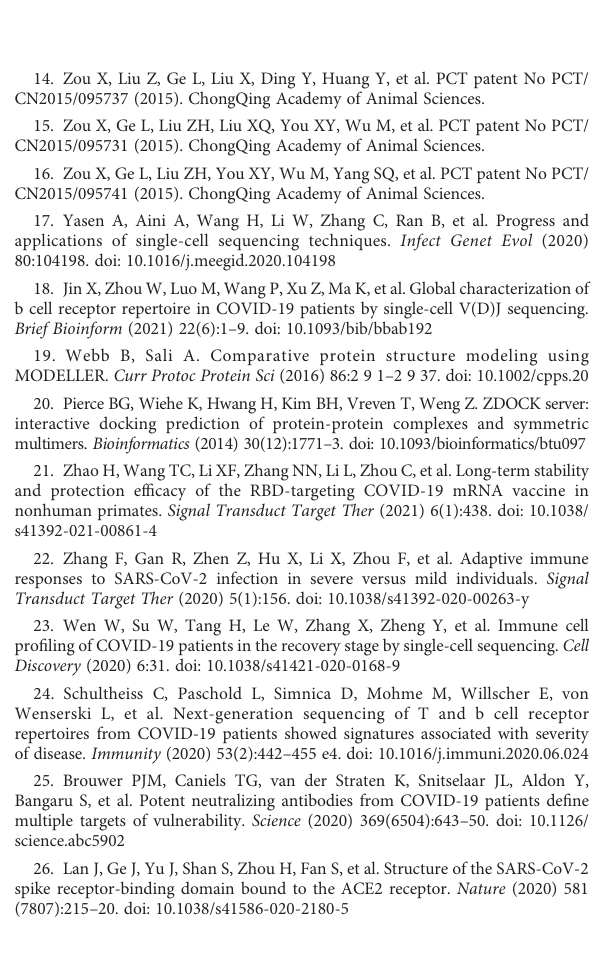
SUPPLEMENTARY FIGURE 1 Flowcytometryanalysis ofantibody bindingactivityto 293T cellstransiently expressing SAR-CoV-2 S protein (293T/S) and untransfected 293T